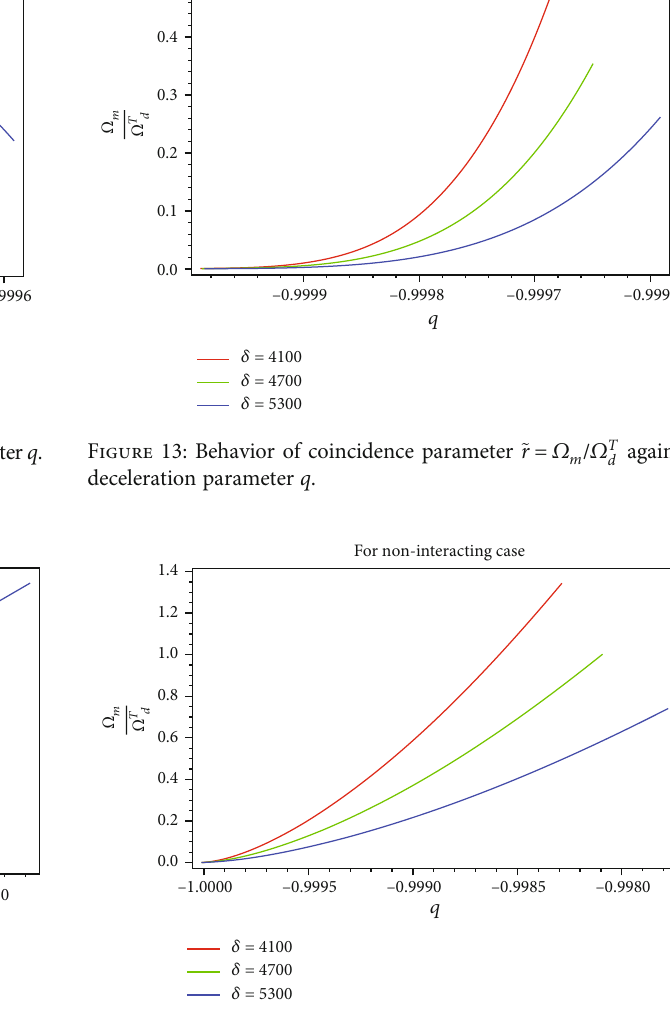
/ Ω T against q m d